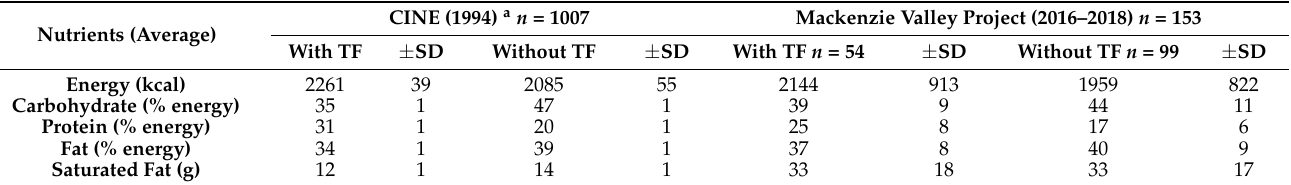
Table 4. Dietary intakes between 1994 (CINE Study) and 2016–2018 (Mackenzie Valley Project) for energy intake, carbohydrate, protein and fat percentage, and saturated fat in Dene/M é tis adults from the NWT.